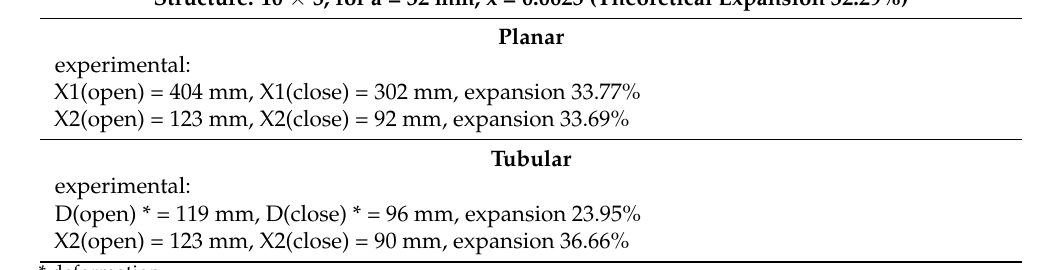
Table 2. Comparison of the measured and theoretical values for the planar structure and the resulting tubular